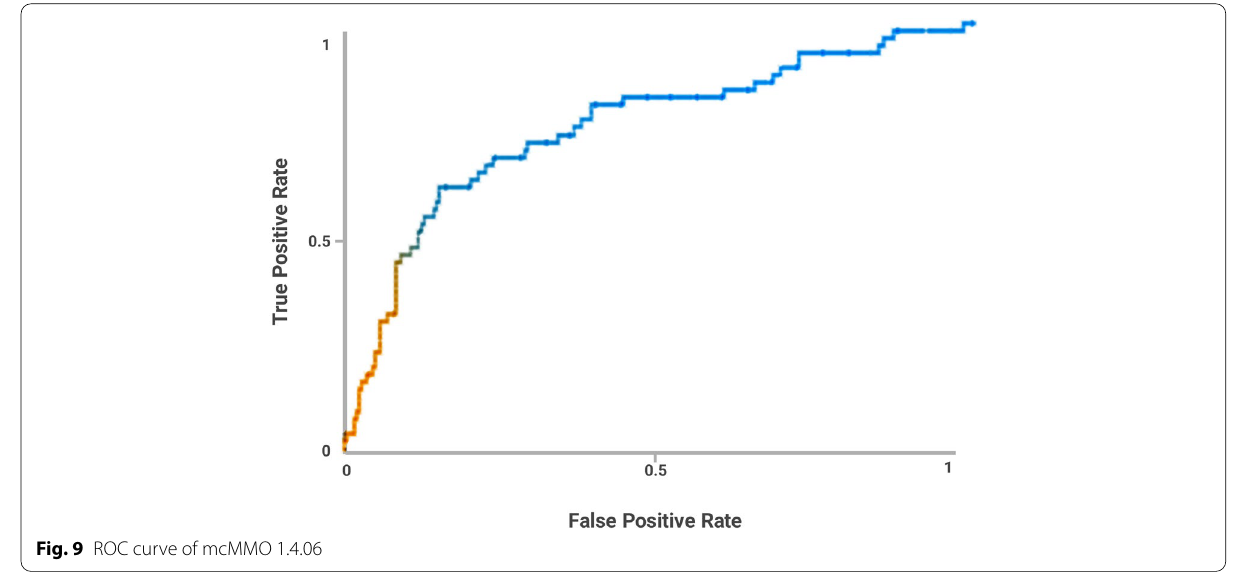
Fig. 9 ROC curve of mcMMO 1.4.06